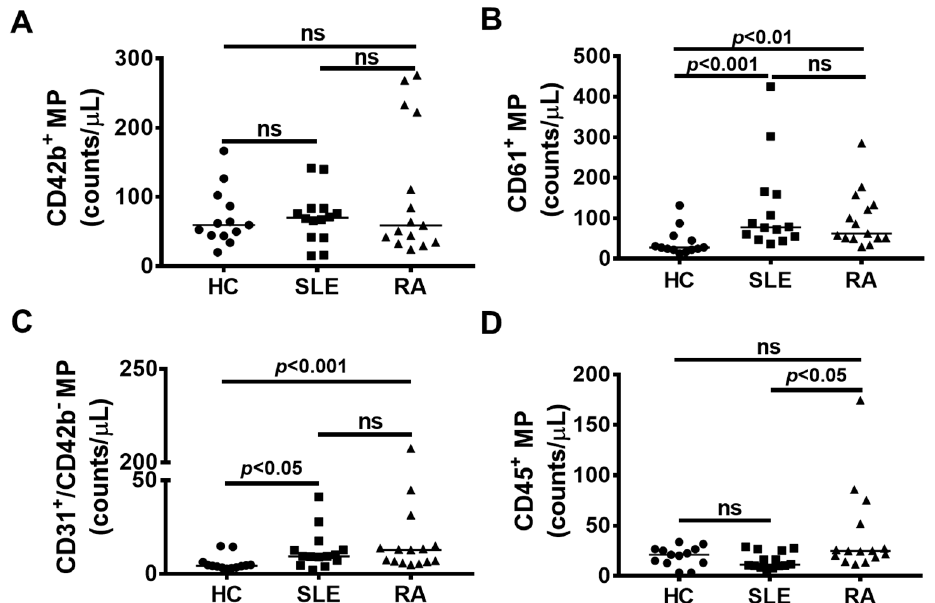
Figure 2. Autoimmune patients have increased platelet-, endothelial- and leucocyte-derived microparticles (MP). Fractions 8 to 13 were pooled and flow cytometry was used to determine the cell of origin of MP. ( A ) There was no significant difference in the quantity of CD42b (platelet GP1b)-derived MP between all groups. ( B ) Both patient groups had increased amounts of ( B ) CD61 (platelet GpIIIa)-derived and ( C ) CD31 + CD42 − (endothelial)-derived MP compared to healthy controls (HC). ( D ) CD45 (leucocyte)-derived MP were increased in rheumatoid arthritis (RA) patients compared to both HC and systemic lupus erythematosus (SLE) patients. The horizontal bar indicates the median; a p value < 0.05 was considered significant. ns = not significant. While data are shown here as the pooled lipoprotein-deficient microparticles, profiling of individual fractions is show in Supplementary Figure S3.